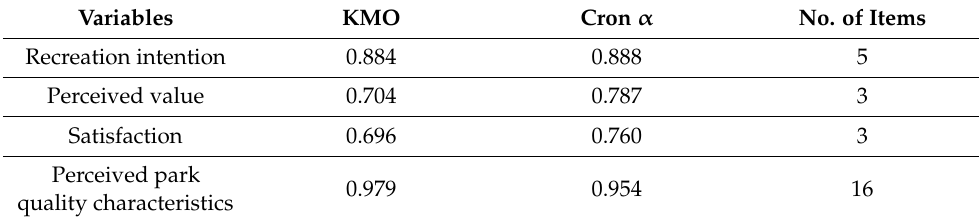
Table A3. Reliability and validity analysis of main variables.